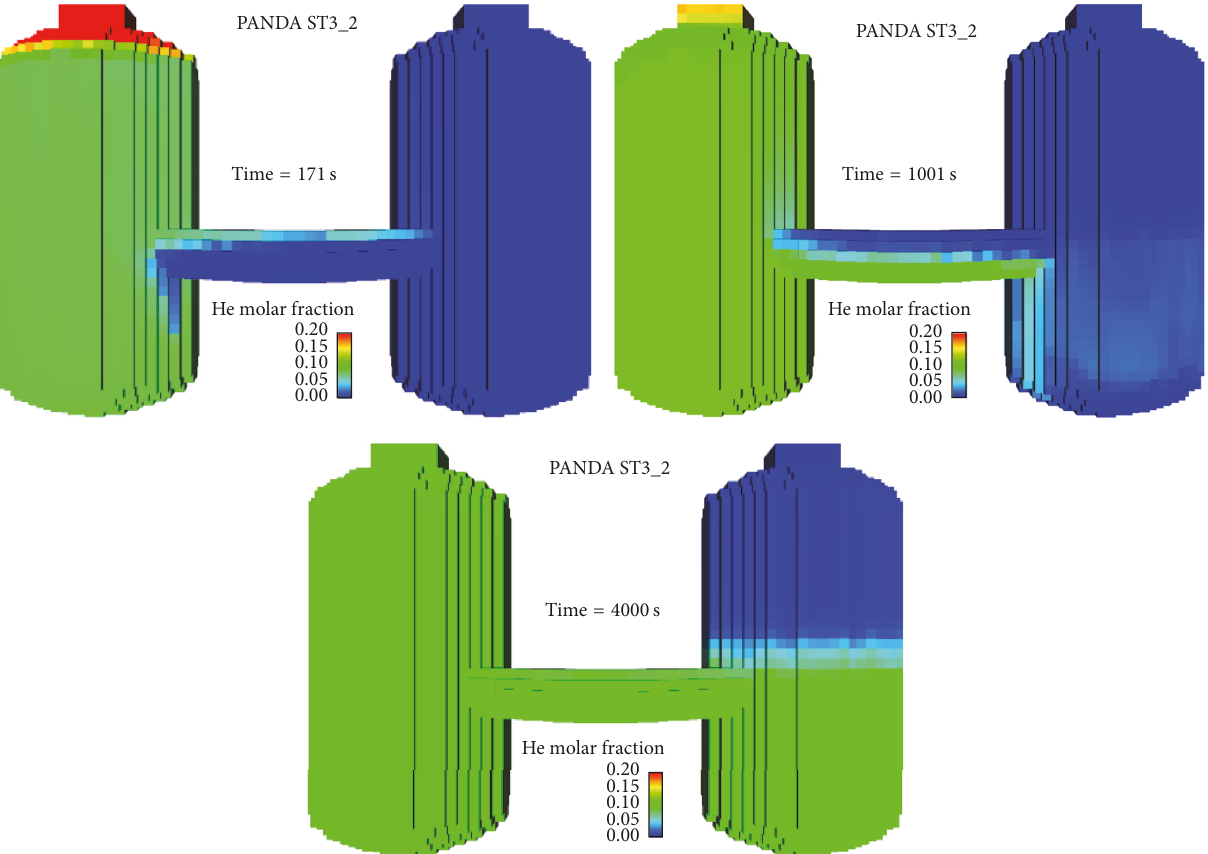
Figure 24: Helium concentration in ST3 2.